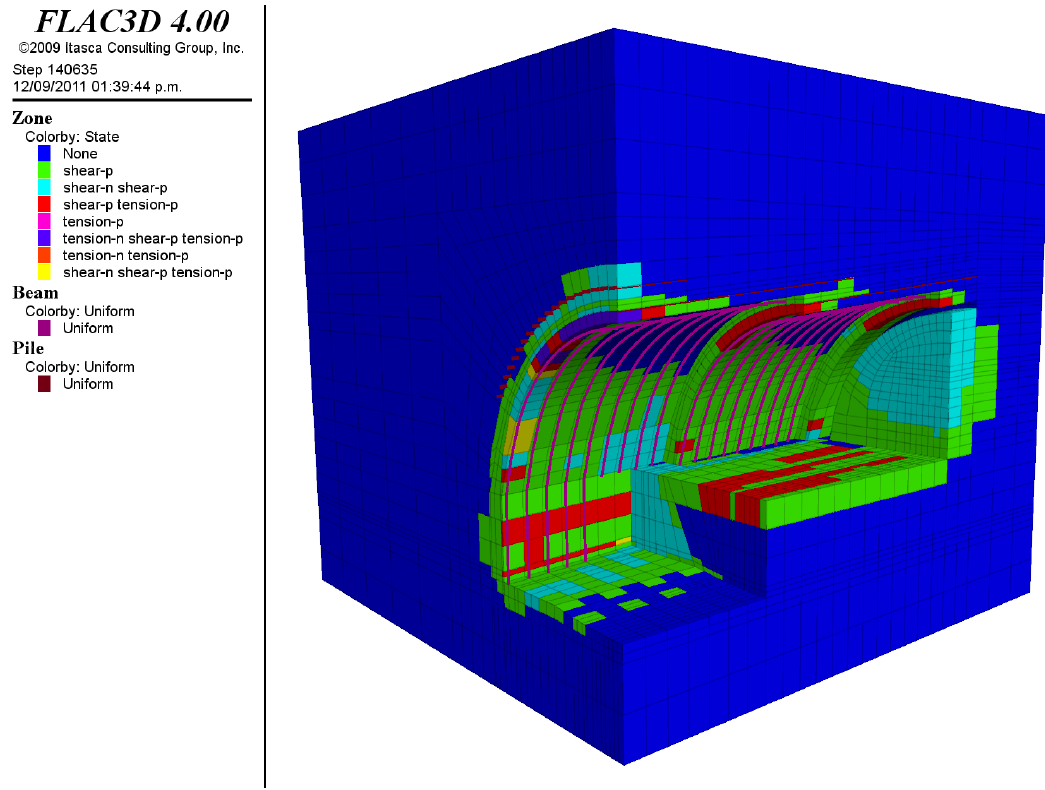
Figure 20. States of plasticization in an intermediate stage of the excavation. Minimum parameters.